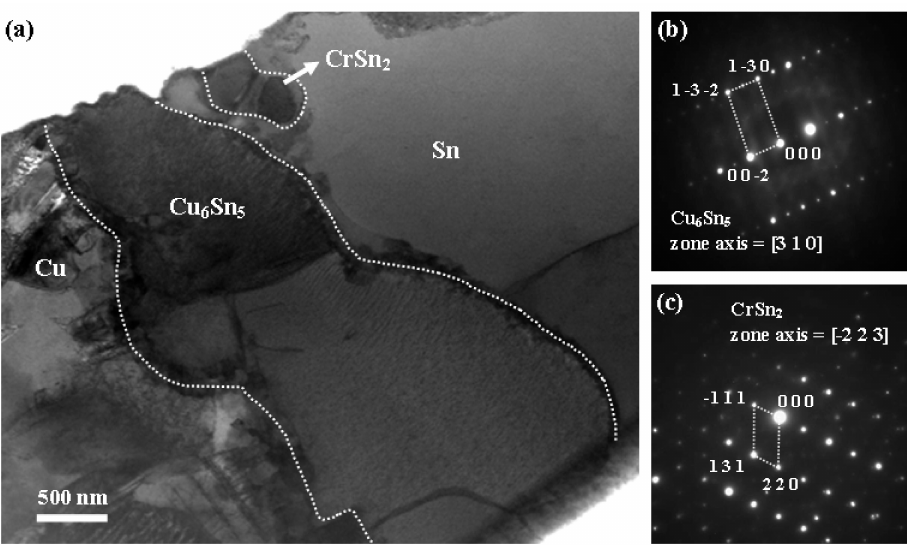
Figure 10. ( a ) TEM bright field image of the interfacial microstructure for the Sn-0.7Cu-0.2Cr solder joint. Selected area electron diffraction patterns for ( b ) Cu 6 Sn 5 and ( c ) CrSn 2